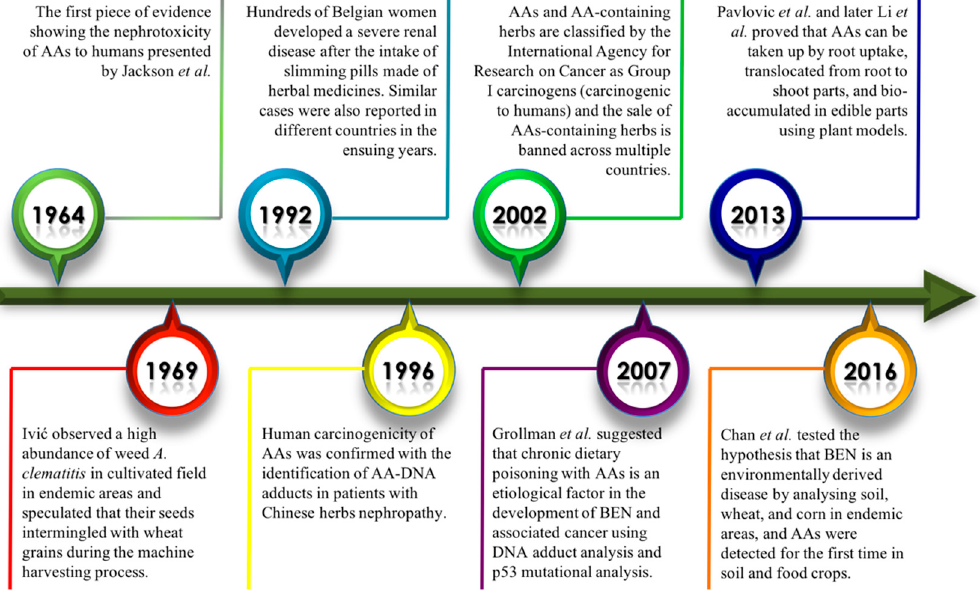
Figure 4. A brief timeline of the discovery of the toxicity of AAs and their occurrence in food and the